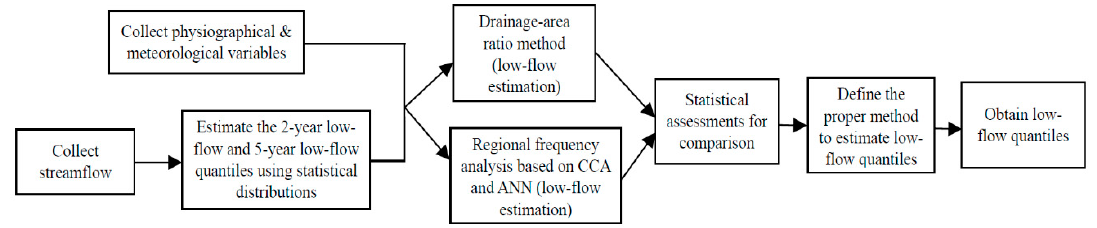
Figure 2. Overall processes to obtain the hydrological variable estimation (low-flow estimation) in this